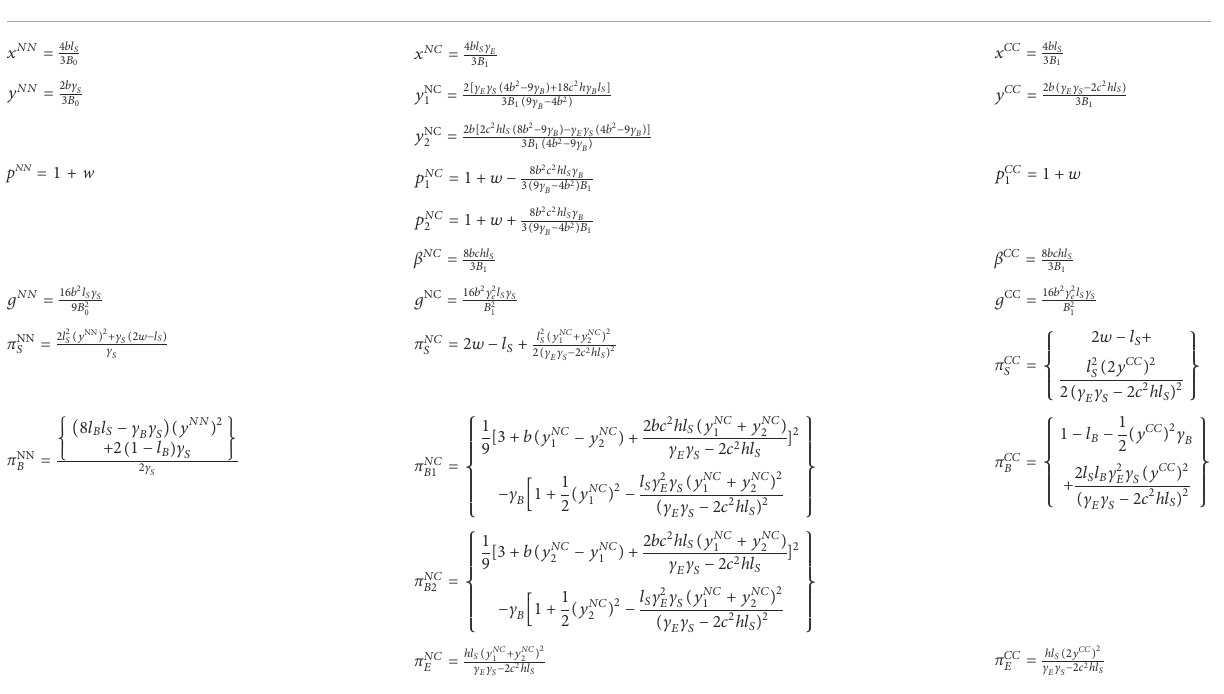
TABLE 5 The equilibrium outcomes in duopoly